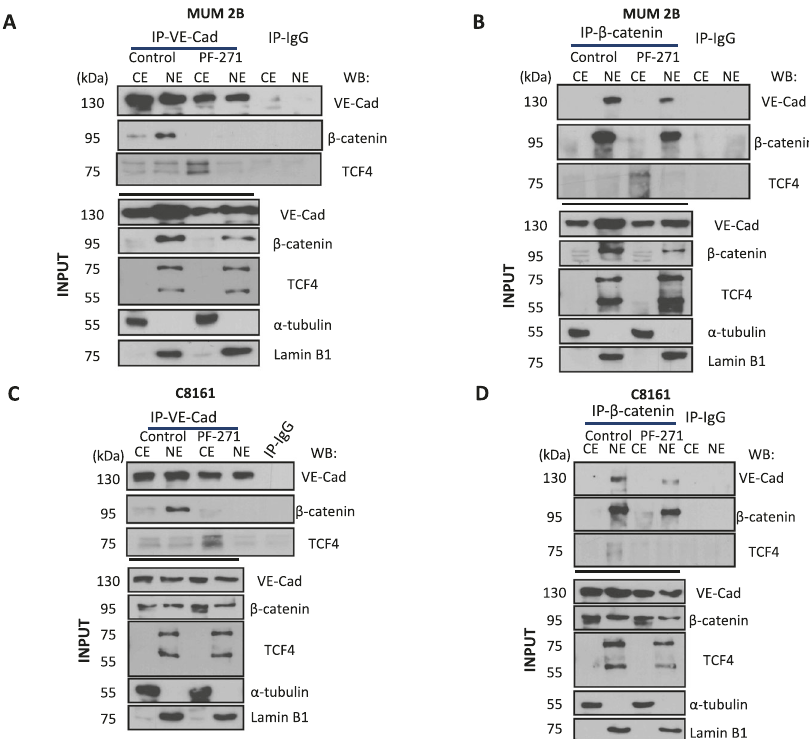
Fig. 3 VE-Cadherin/ β -catenin forms a complex in FAK-dependent manner to enhance TCF-4 transcription activity. A Immunoprecipitation after cytosol-nucleus fractionation of VE-Cadherin or β -catenin B in MUM 2B cells, input was used to protein expression controls, α -tubulin cytosol control or lamin B1 nucleus control. C Immunoprecipitation after cytosol-nucleus fractionation of VE-Cadherin or β -catenin D in C8161 cells, input was used for protein expression controls, α -tubulin cytosol control or lamin B1 nucleus